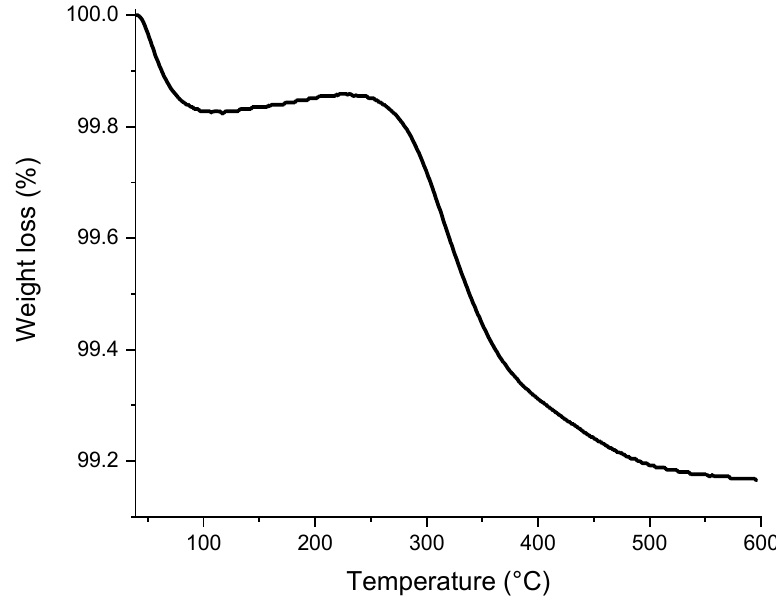
Figure 6. TGA of SnO 2 nanoparticles.